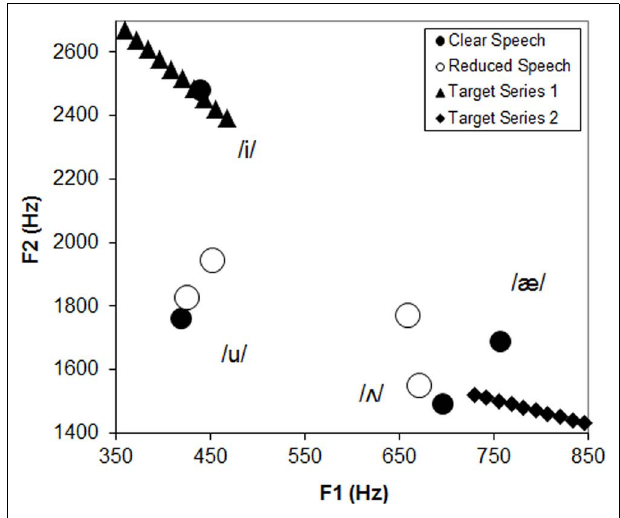
FIGURE 3 |Vowel space plotting the F1 and F2 values for four vowels selected from the carrier phrases in their clear and reduced forms along with values for target